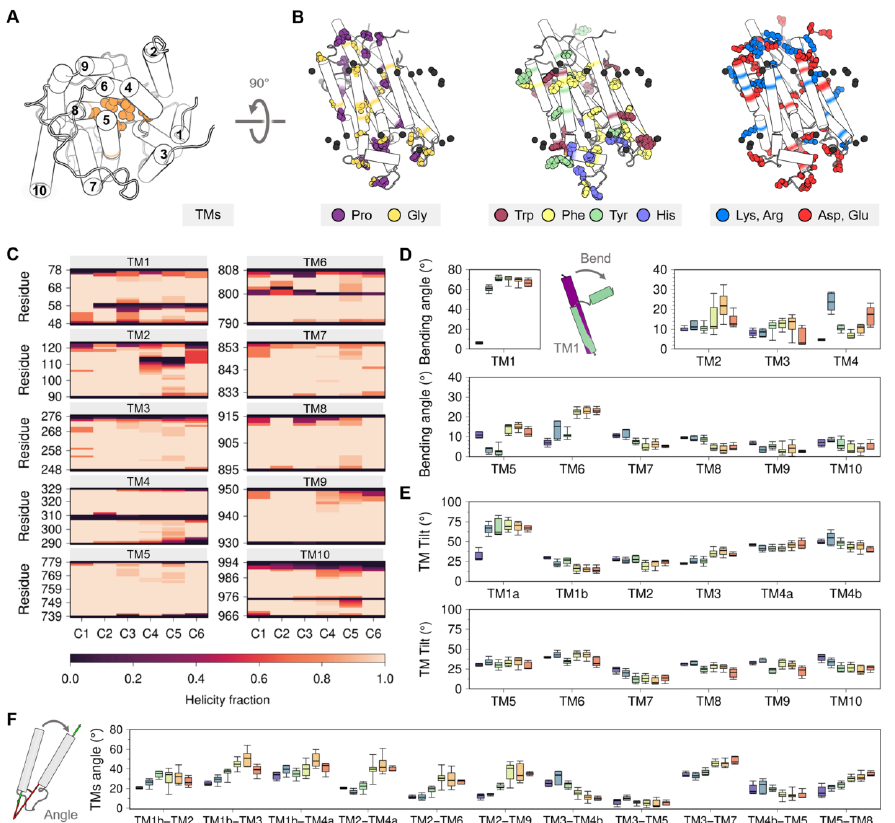
Figure 4. ( A ) Cytosolic view of the transmembrane domain with labeled TM helices. ( B ) Topological distribution of proline, glycine, aromatic, and charged residues. ( C ) Average helicity fraction of the TM helices in the six clusters. Distribution of the ( D ) bending and ( E ) TM tilt angles of the ten TM helices. ( F ) Angle between the helices of most representative TM helix pairs. Box and whisker plots are colored using the cluster analysis in Figure 2 as reference ( C1 , purple; C2 , blue; C3 , green; C4 , yellow; C5 , orange; C6 ,